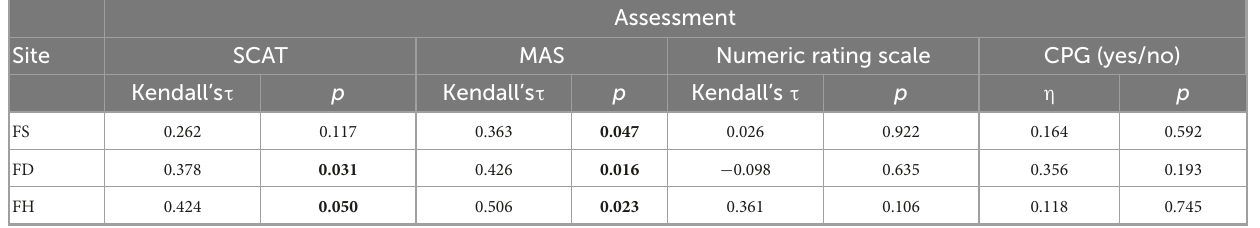
TABLE 5 Relation between reflex response rates and clinical